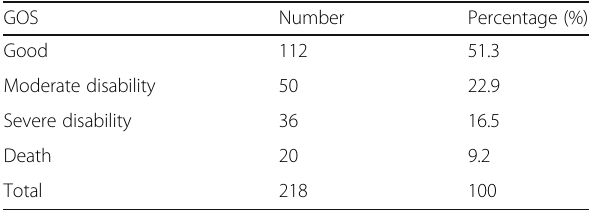
Table 4 Glasgow outcome scale (GOS) within 6 months management of